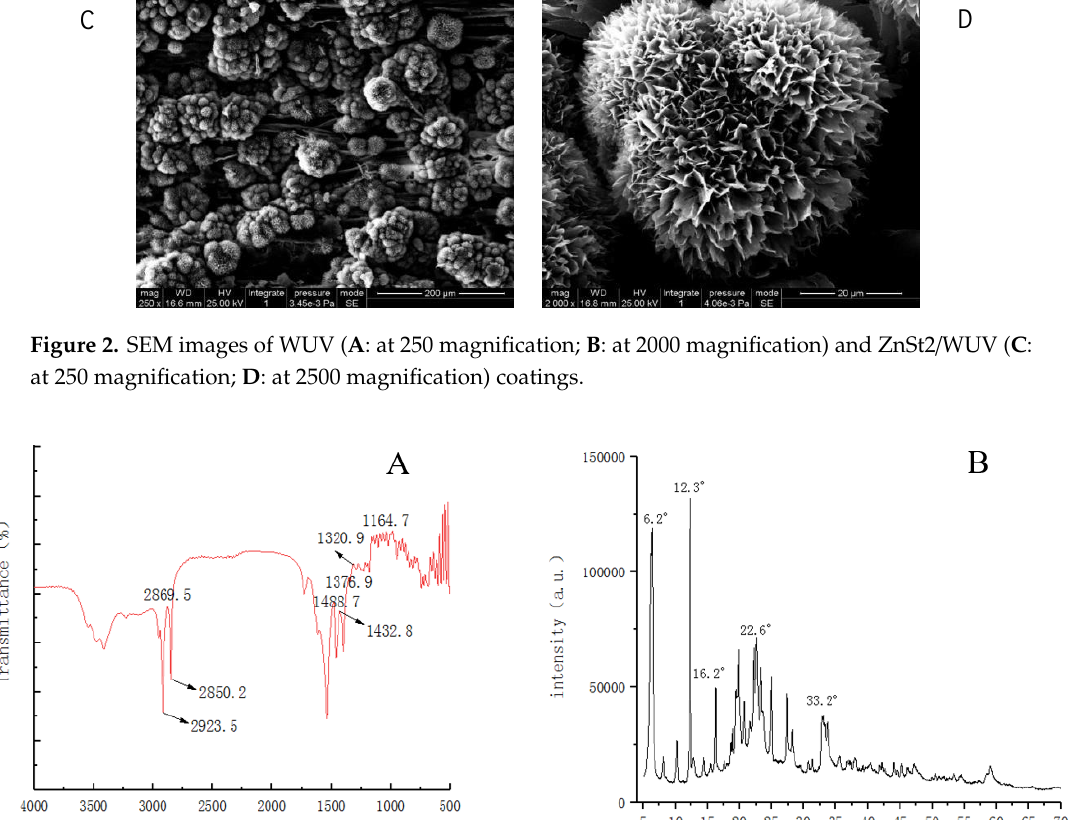
Figure 2. SEM images of WUV ( A : at 250 magnification; B : at 2000 magnification) and ZnSt2/WUV ( C : at 250 magnification; D : at 2500 magnification) coatings.